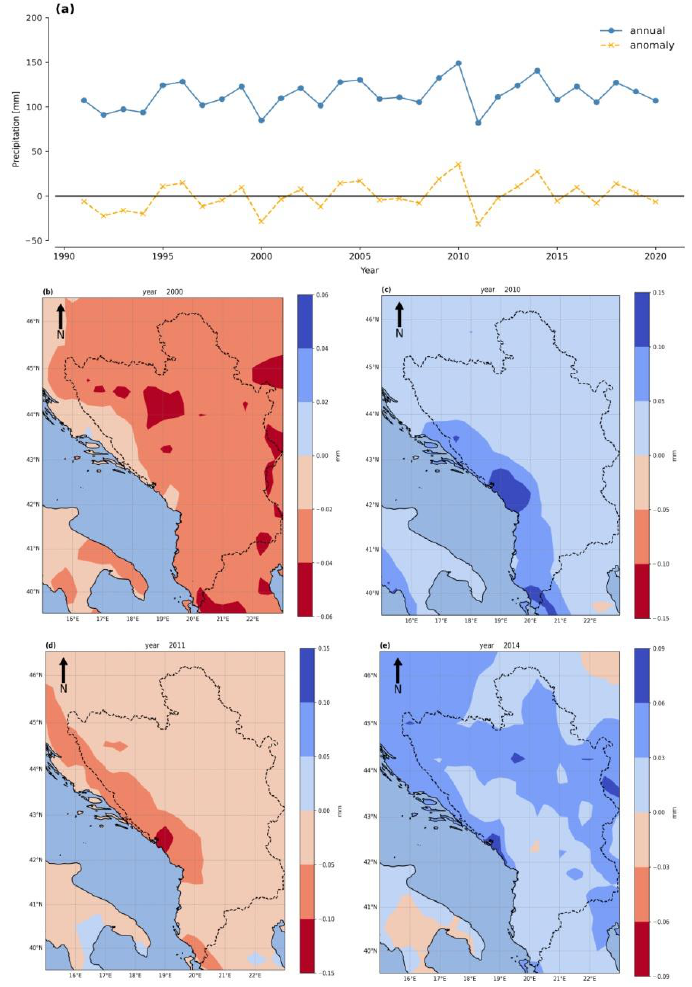
Figure 5. Anomaly variation based on average total annual distribution of hourly precipitation for the total study area ( a ) and years with maximum (2010, 2014) and minimum (2000, 2011) anomalies pronounced ( b – e ).